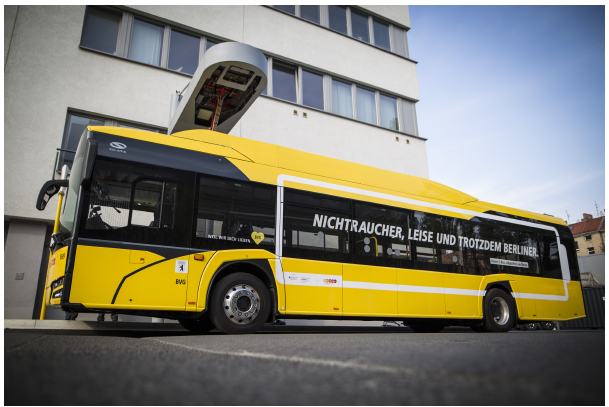
Figure 3. Solaris Urbino 12 e-bus (copyright Phototek|Fotographie & Film).